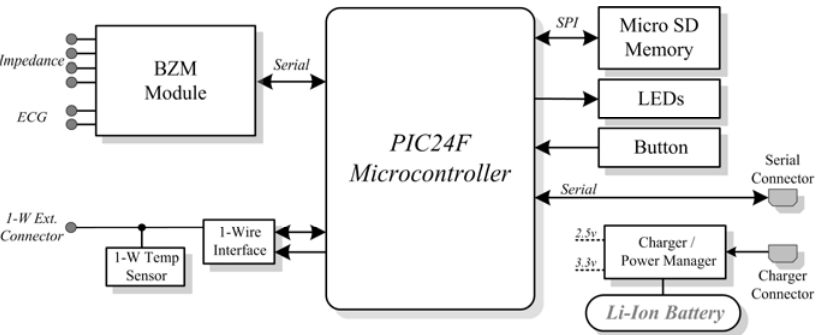
Figure 5. Block diagram of the ECG-Impedance